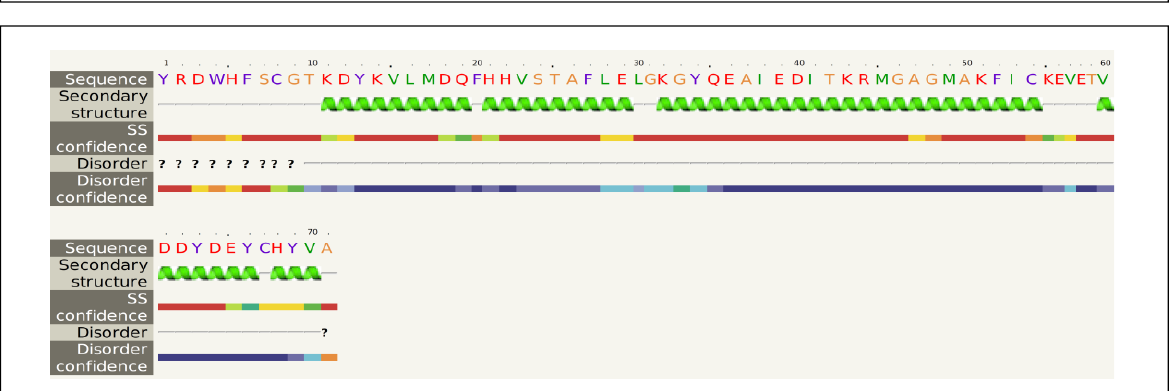
Figure 9: Hydropathy plot of Mc Squlaene Synthase (McSQS). The values above zero indicates the presence of hydrophobicity